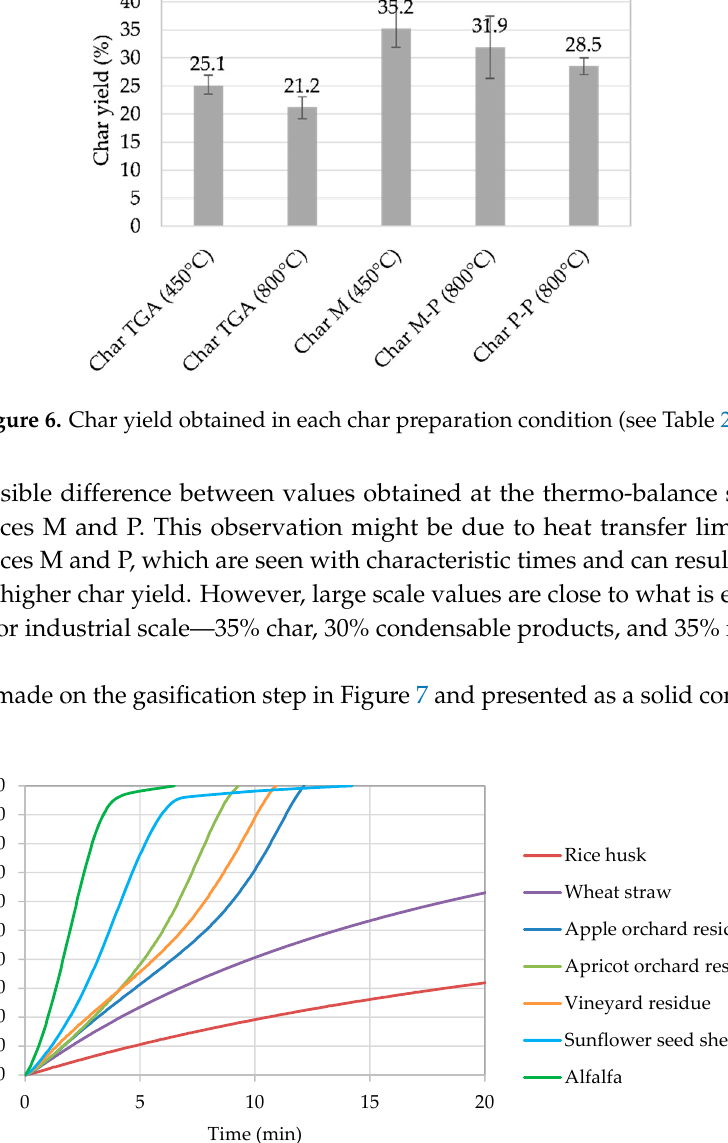
Figure 5. TGA of biomass samples presented as a mass loss and as a function of time . Pyrolysis: 0.05 L·min − 1 N 2 , 24 °C/minutes, 1 h hold at 450 °C, 15-min hold at 800 °C. Gasification: 0.05 L·min − 1